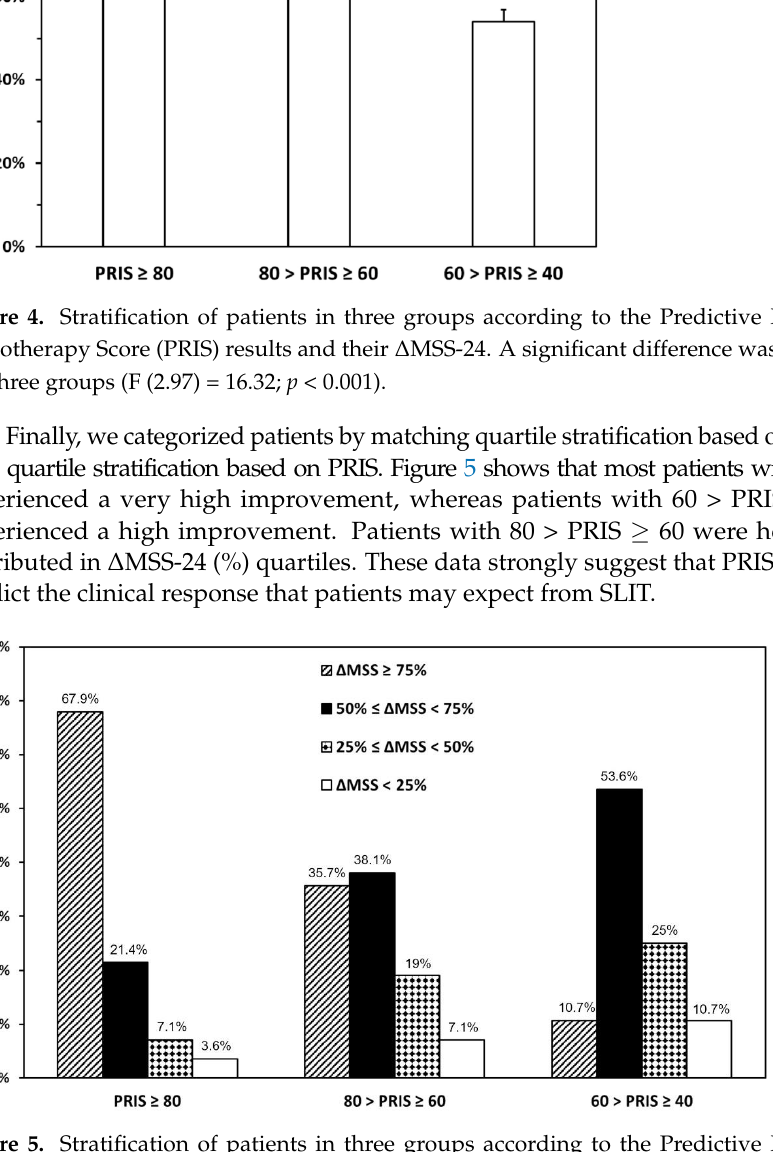
Figure 5. Stratification of patients in three groups according to the Predictive Response to Immunotherapy Score (PRIS) results and their ΔMSS-24. Most patients with a PRIS ≥ 80 experienced a very high improvement, whereas patients with 60 > PRIS ≥ 40 mostly experienced a high improvement. Patients with 80 > PRIS ≥ 60 were homogeneously distributed in ΔMSS-24 (%) quartiles.